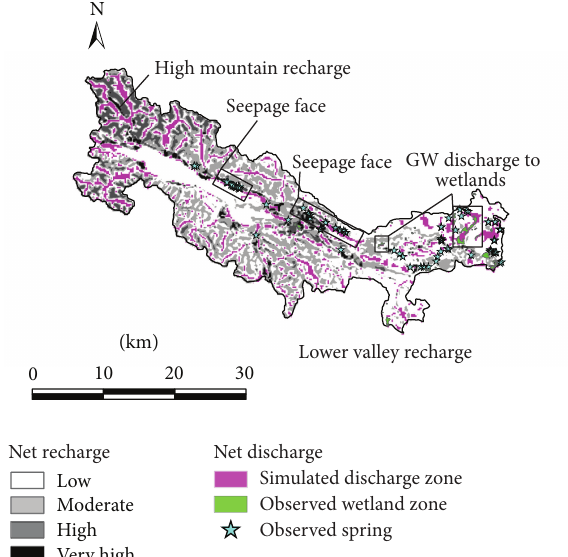
Figure 12: Averaged (2002–2012) and classified spatial distribution of recharge and discharge throughout the Cowichan